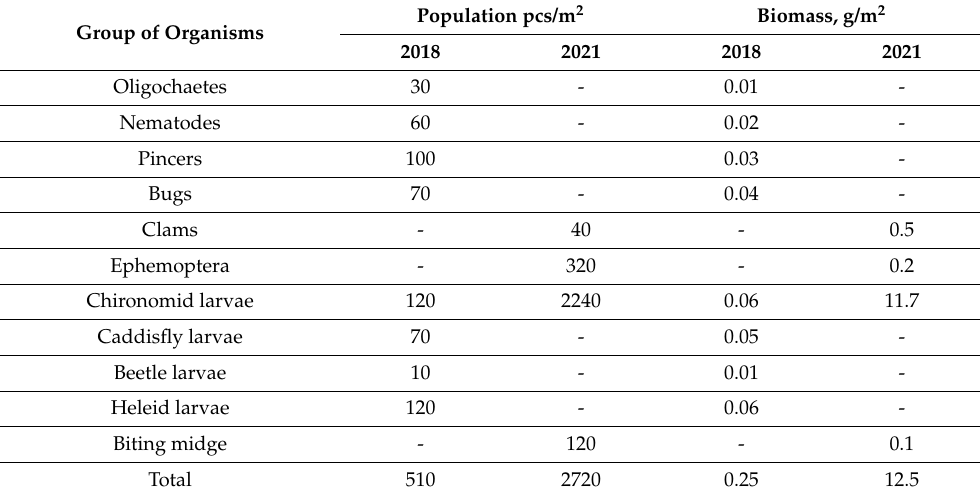
Table 3. Quantitative development of zoobenthos in the Tokyrauyn River (average